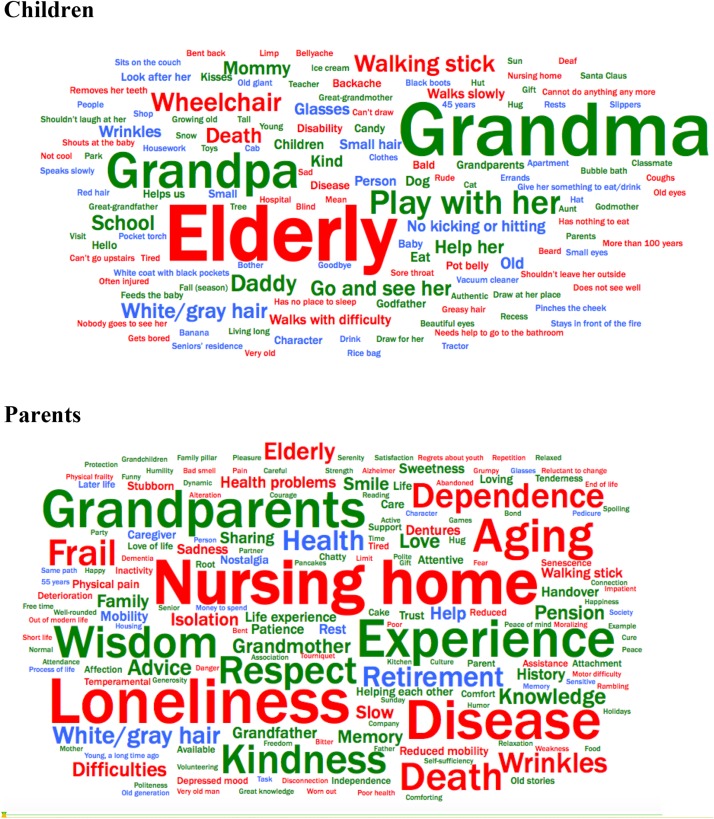
Clouds of words produced by children and parents at the Image-of-Aging question, asking them to cite the first 5 words that came to their mind when thinking of an old person. Clouds were generated by translated versions of the French words cited. The color of each word represents its valence; Red denotes negative words (–5 to –1), green denotes positive words (+1 to +5), and blue denotes neutral words (–0.99 to +0.99). The size of each word is correlated with its frequency (i.e., the more often a word was cited, the larger its size). For instance, in the children’s cloud, Elderly is the most frequently cited word (9.4% of all citations) and was given a valence of –2.2 (on a scale of –5 to +5); Grandma (9.1%), a valence of +2.9; and Grandpa (6%), a valence of +2.5. In the children’s cloud, regardless of the gender stated by the child, the gender was made uniform (to feminine) when the cloud was created, for better visual consistency.